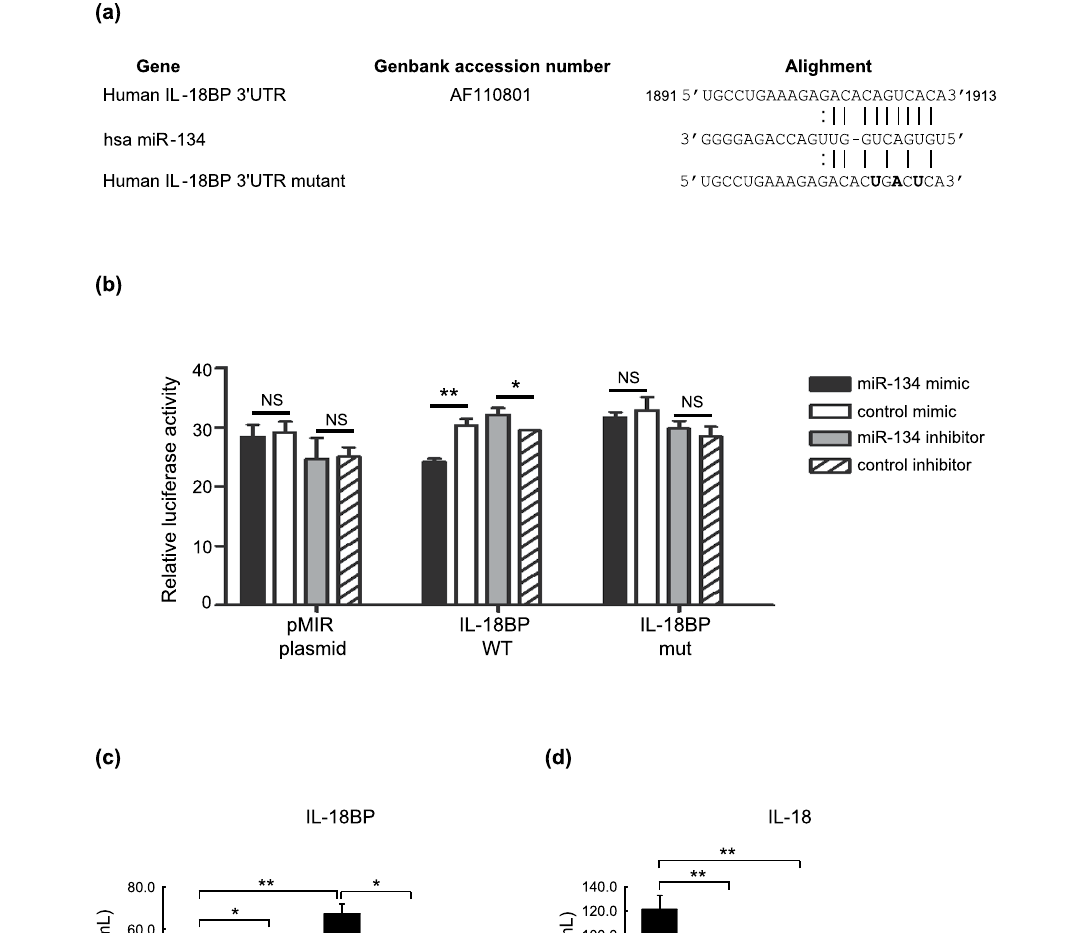
ing has no statistical significance, lower plasma levels of IL-18BP were observed in active AOSD patients (mean, 4441.6 pg/ml) compared to inactive AOSD patients (5572.5 pg/ml, P = 0.155).